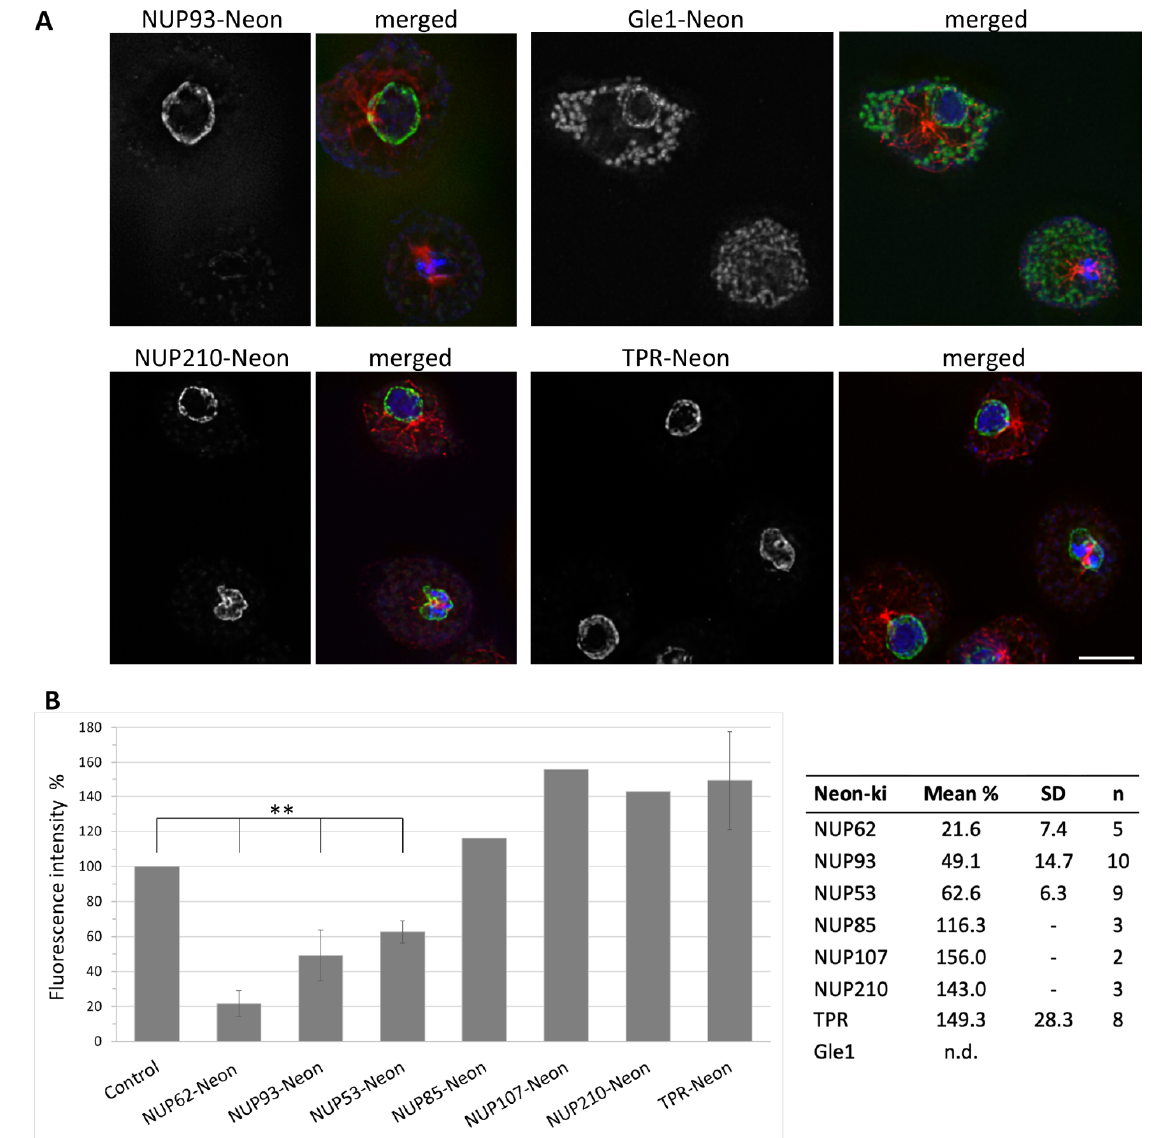
Figure 4. NUP93 and Gle1 disappear from the nuclear envelope during mitosis, whereas NUP210 and TPR remain. ( A ) Immunofluorescence microscopy of Neon knock-in cells fixed with glutaraldehyde, stained with anti- α -Tubulin and secondary antibodies anti-rat-AlexaFluor-568. One metaphase cell and neighbouring interphase cells are shown. Maximum intensity projection of the slices containing the nuclei. Overlay of the green fluorescent protein signal (green) with α -Tubulin (red) and DAPI (blue). Bar = 5 µ m. ( B ) Quantification of the fluorescence intensity signal of respective NUP-Neon knock-in cells during metaphase. Columns represent the mean fluorescence intensity measured from widefield microscopy images. For each mitotic cell the fluorescence intensity of a neighboring interphase cell was measured and normalized to 100% (Control). Mean values and standard deviation (SD) are shown in the table. Due to a lack of Gle1 signal during metaphase, there are no measurements available. n = sample number, SD was calculated only for n > 4; n.d. = not defined. Error bars represent standard deviation of the mean. One-sample t test; ** p value <